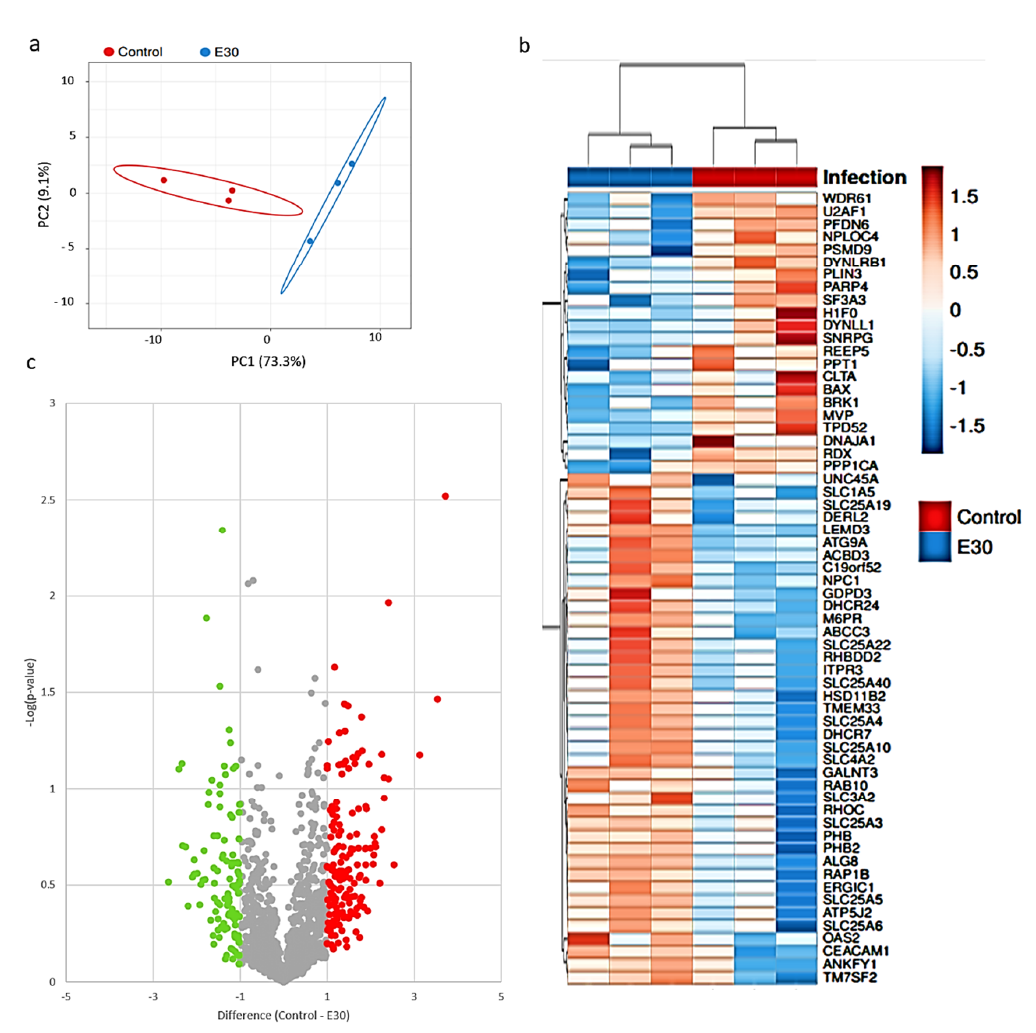
Figure 4. E-30 infection of HIBCPP cells alters the abundance of protein at the lipid raft micro-domains. ( a ) Plot of the principal component analysis (PCA) for the uninfected samples (red) versus E-30 MOI 20 (blue). ( b ) Heatmap representing the significantly up-regulated (in red) and down-regulated (in blue) proteins of HIBCPP cells infected with E-30 MOI 20 versus uninfected control. Proteins with a p -value < 0.01, and a | log2FC | > 1 were considered as di ff erentially expressed. ( c ) Volcano plot representing proteins found to be down-regulated (in green) and up-regulated (in red) when comparing the uninfected control versus E-30 MOI 20 infected cells. Proteins in gray are not significantly changed. Proteins with a t -test p -value lower than 0.01, and an absolute di ff erence greater than 1 were considered as di ff erentially expressed. Statistical analysis was performed using Perseus framework (version: 1.5.2.4).